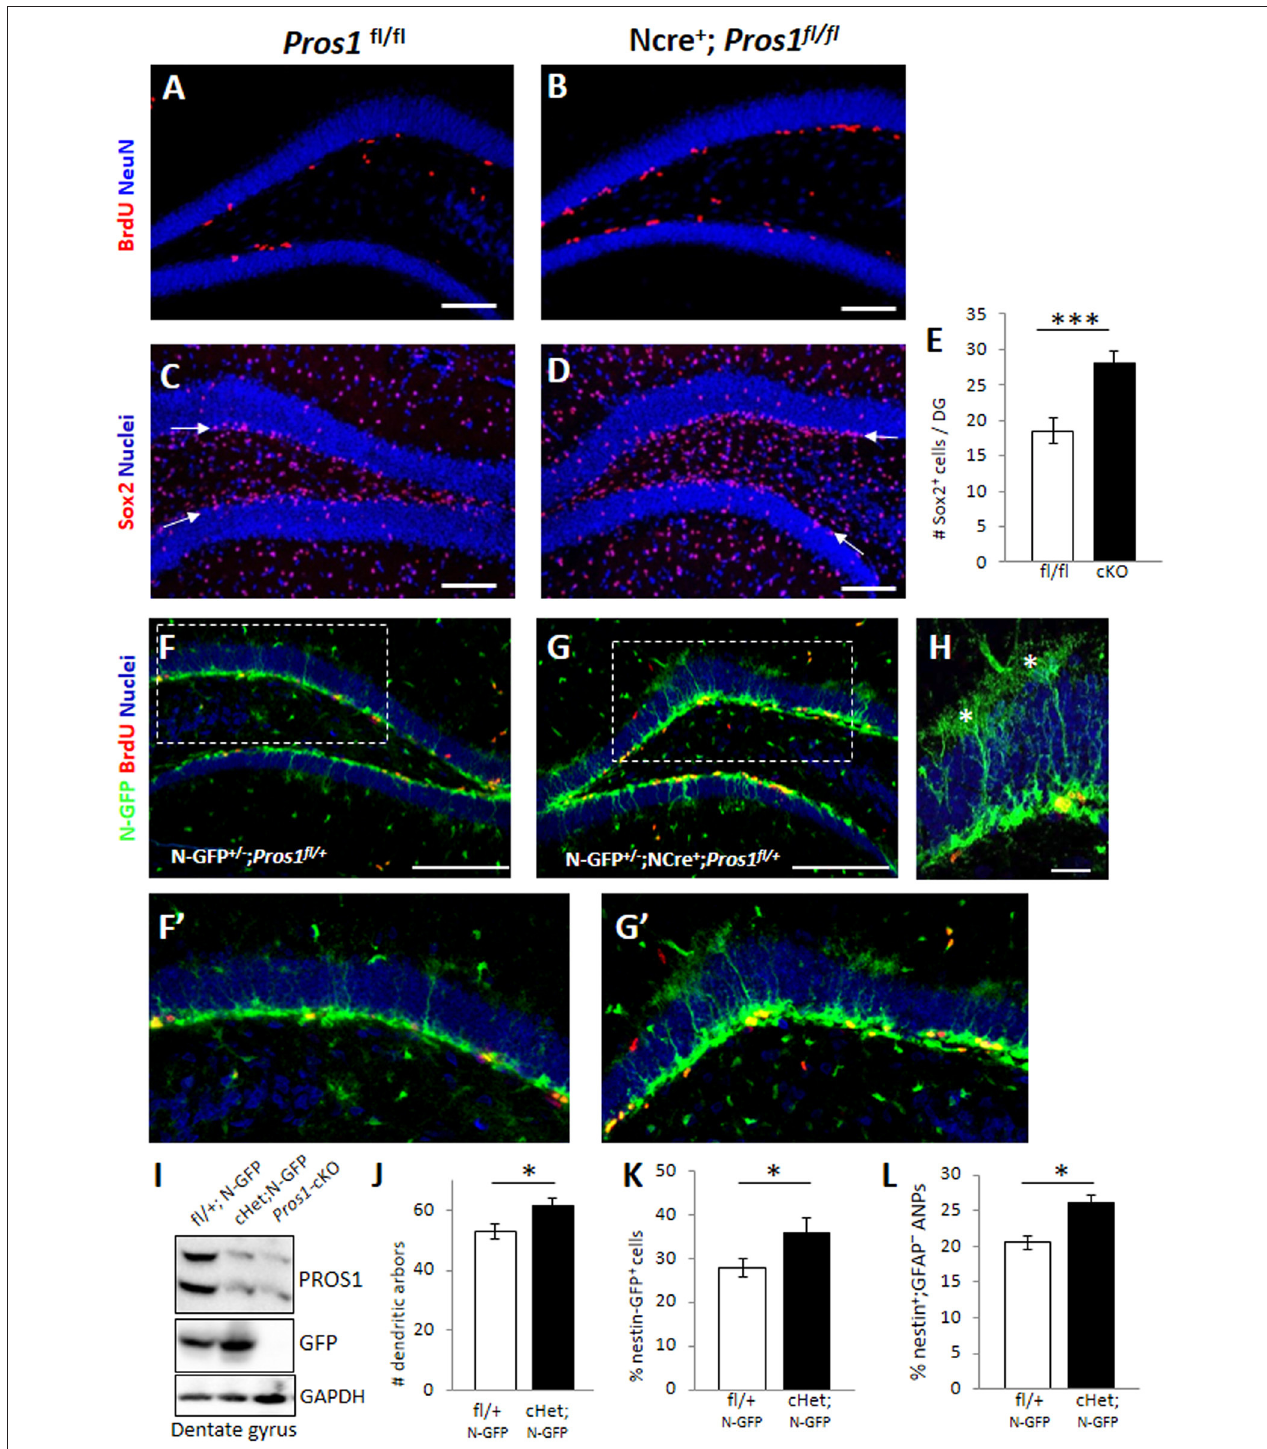
FIGURE 1 | Deletion of Pros1 in neural cells leads to superfluous hippocampal neural stem cells. (A,B) Confocal images of adult hippocampus showing BrdU-positive cells (red) in Pros1 fl / fl (control, A ) and Pros1 -cKO (B) adult mice. The dentate gyrus is delineated by NeuN immune-reactivity (blue). Mice were injected with BrdU for three consecutive days and analyzed 24 h after the last BrdU injection. (C–E) Increased Sox2 + cells in the SGZ of Pros1- cKO mice. Confocal images of Sox2-labeled cells (red) in control (C) and Pros1 -cKO (D) adult SGZ. Nuclei are stained with Hoechst (blue). Arrows point to the SGZ. (E) Quantification of sox2 + cells in the SGZ). Bars represent the mean values ± SEM from six mice per genotype. *** P < 0.0001. Scale bar: (A–D) = 100 µ m. (F–H) Representative confocal images